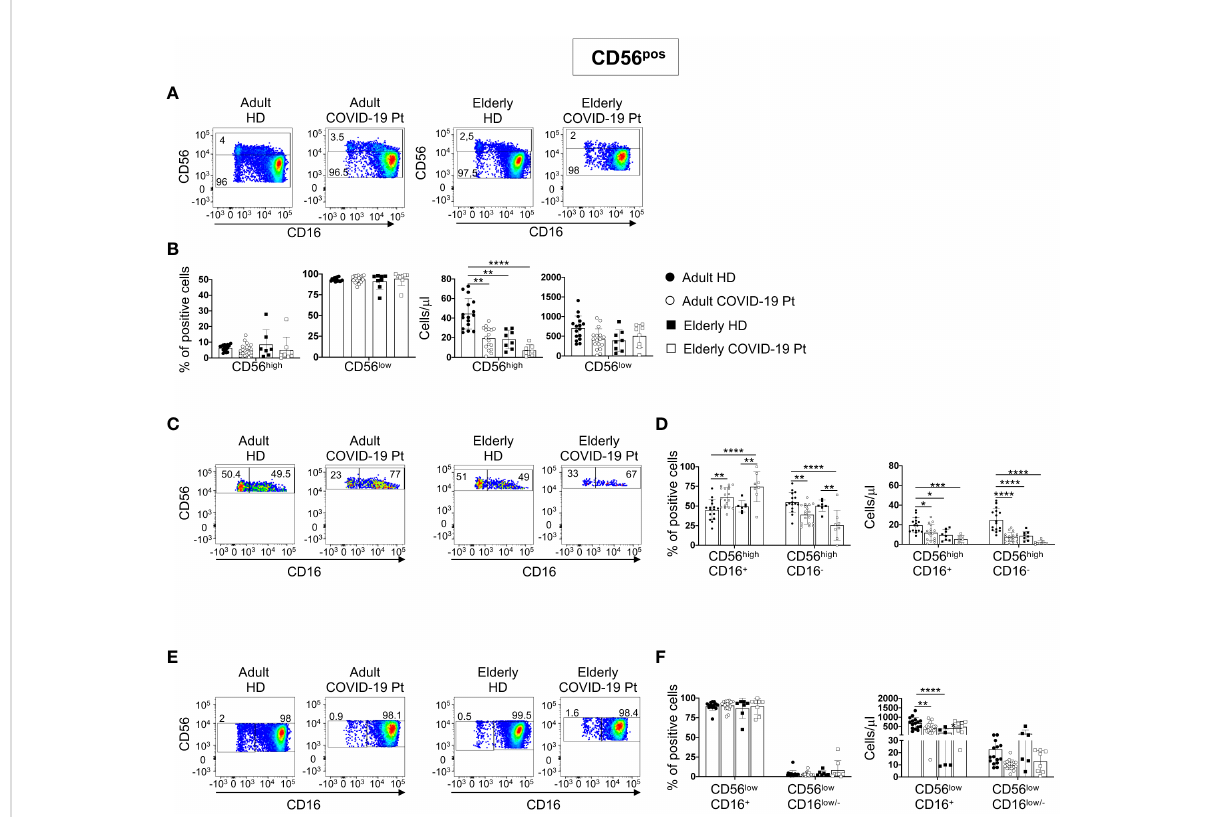
FIGURE 3 Alterations in circulating CD56 pos cells in adult and elderly COVID-19 patients at hospital admission. Gating strategies used to identify total and relative frequency of CD56 high and CD56 low cell populations and their subsets are shown on a representative adult c COVID-19 patient and age- matched controls (A, C, E) . CD56 high and CD56 low cell populations were gated on Lin - CD45 + CD7 + CD56 + and distinguished based on CD16 expression. Frequency and total cell count/ m l of total CD56 high and CD56 low cell (B) as well as of speci fi c subsets CD56 high CD16 + and CD56 high CD16 - (D) , and CD56 low CD16 + and CD56 low CD16 low / - (F) in COVID-19 patients and healthy donors are shown. Histograms show mean ± SD. * p< 0.05, ** p< 0.01, *** p< 0.001, **** p< 0.0001. Two-way analysis of variance (ANOVA) Tukey ’ s multiple comparisons test and One way ANOVA Kruskal-Wallies test multiple